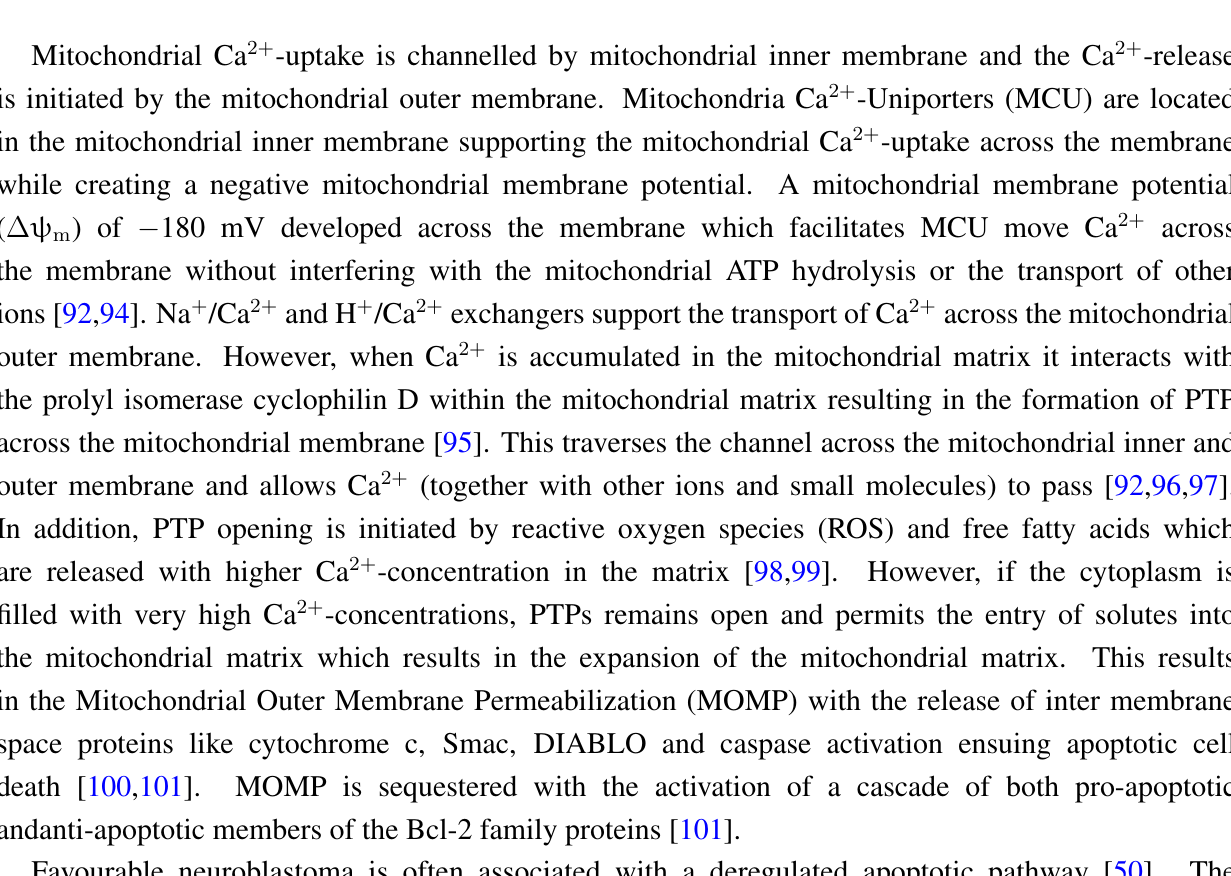
Figure 4. [Ca 2+ ] i as a possible drug target: [Ca 2+ ] i is involved in the signalling pathway of neuroblastoma pathophysiology and could be a possible drug target for the treatment of neuroblastoma.